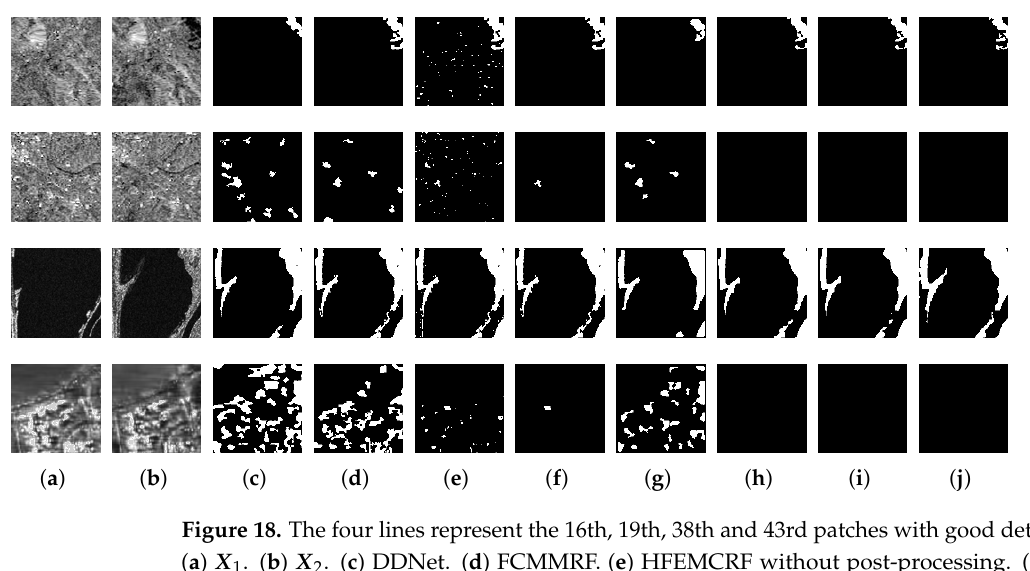
Figure 18. The four lines represent the 16th, 19th, 38th and 43rd patches with good detection results.